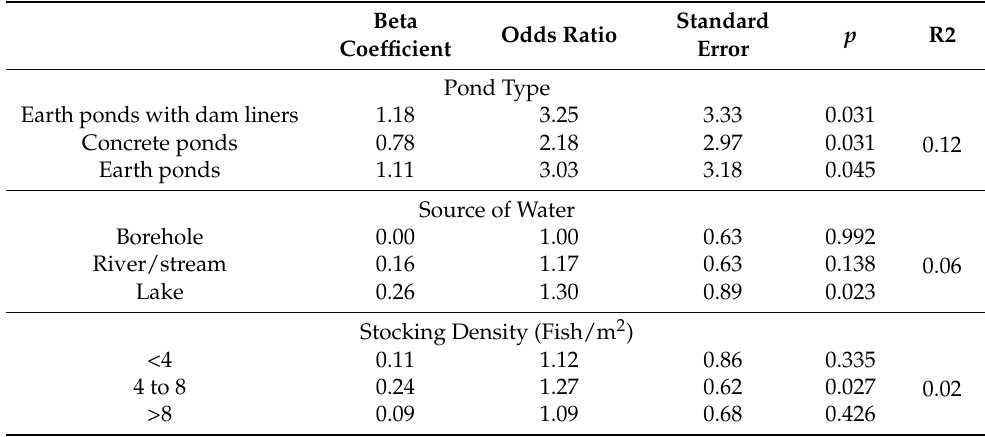
Table 7. Factors associated with the duration (days) of high-mortality